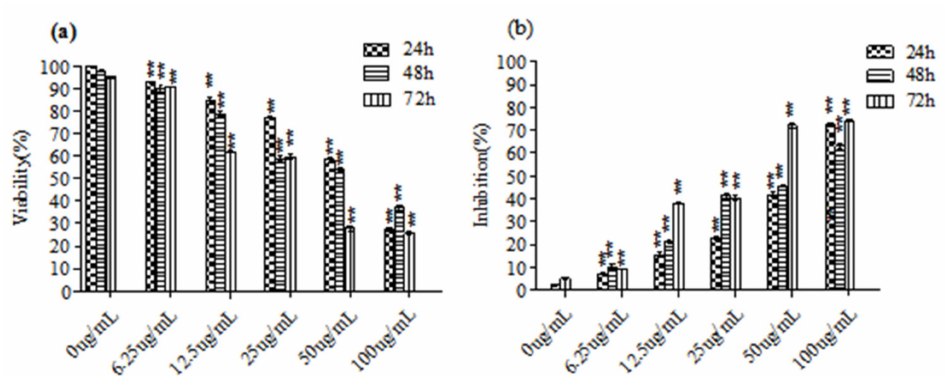
Figure 1. Inhibitory effect of the essential oil from C. ambrosioides on proliferation of the L02 cells. L02 cells were treated with the essential oil for 24, 48, and 72 h, and cell viability was determined by MTT assay. ( a , b ) represented the cell viability and inhibition of the L02 cells after being treated with the essential oil at different concentrations for different time respectively. The graphical plots derived from three independent experiments are shown, and the numerical values represent the means ± SEM (** p < 0.01, compared with the negative